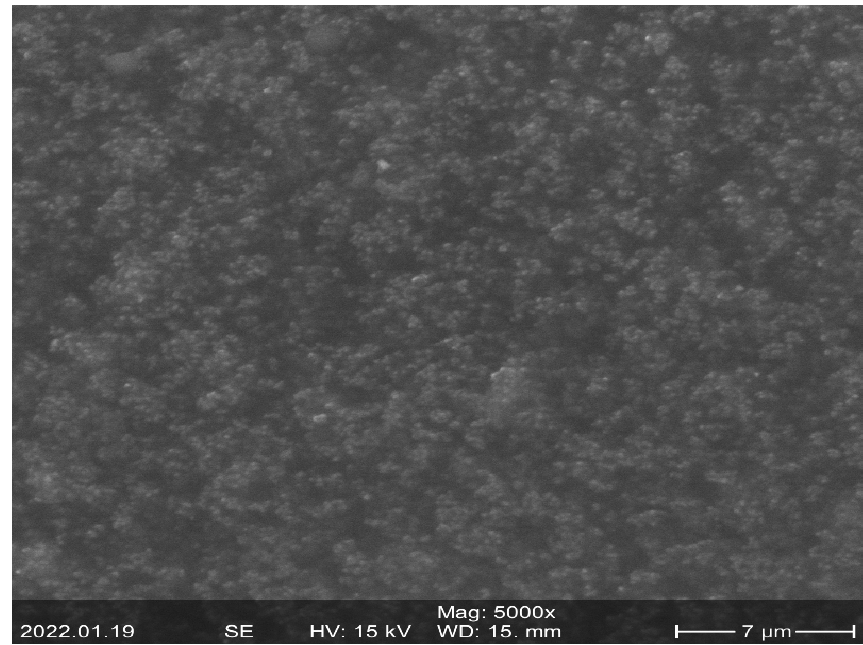
Figure 3. The surface morphology of the piezoresistive film.